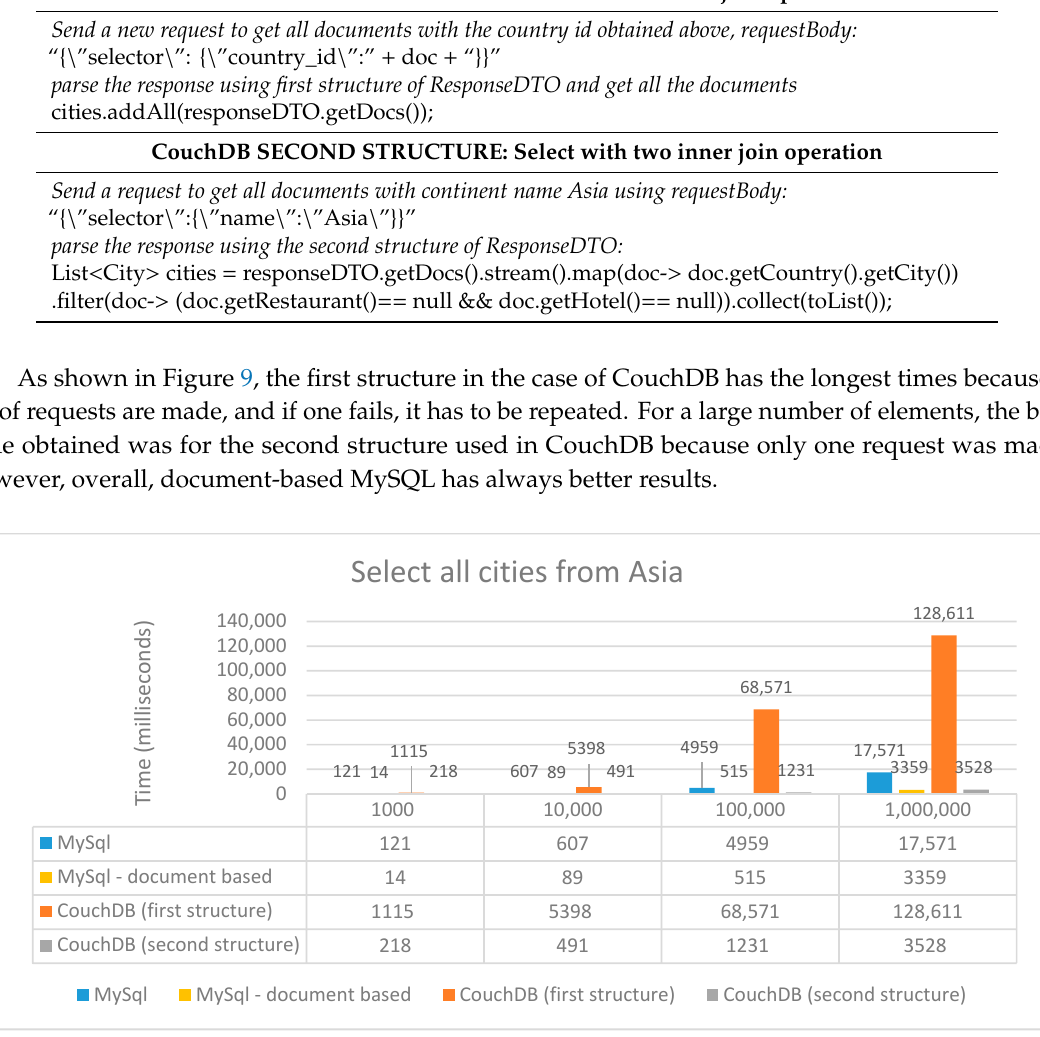
Table 7. Complex select with three inner join operations.